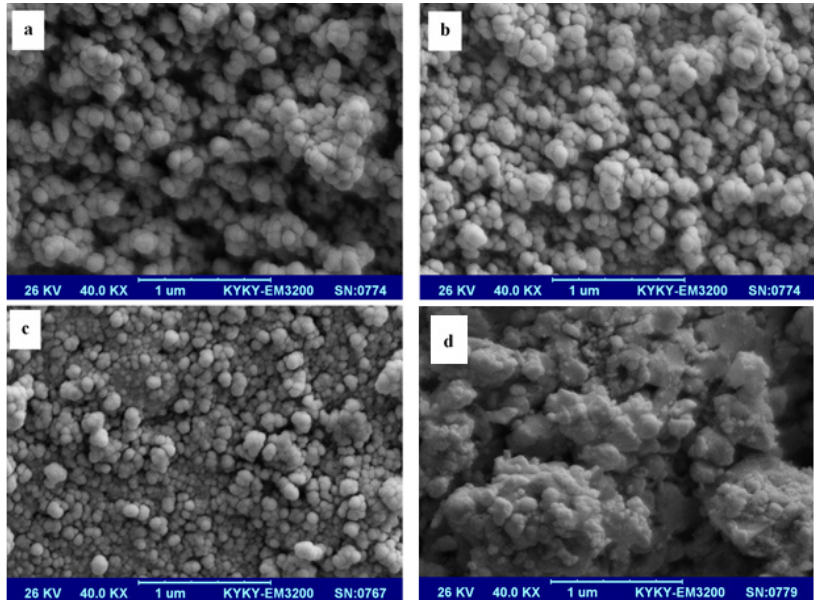
Fig. 4. SEM images of nanoemulsion (II) with chitosan after 5o days at the temperature of a) -20 Co, b) -4 Co, c) 15 Co, and d) 38